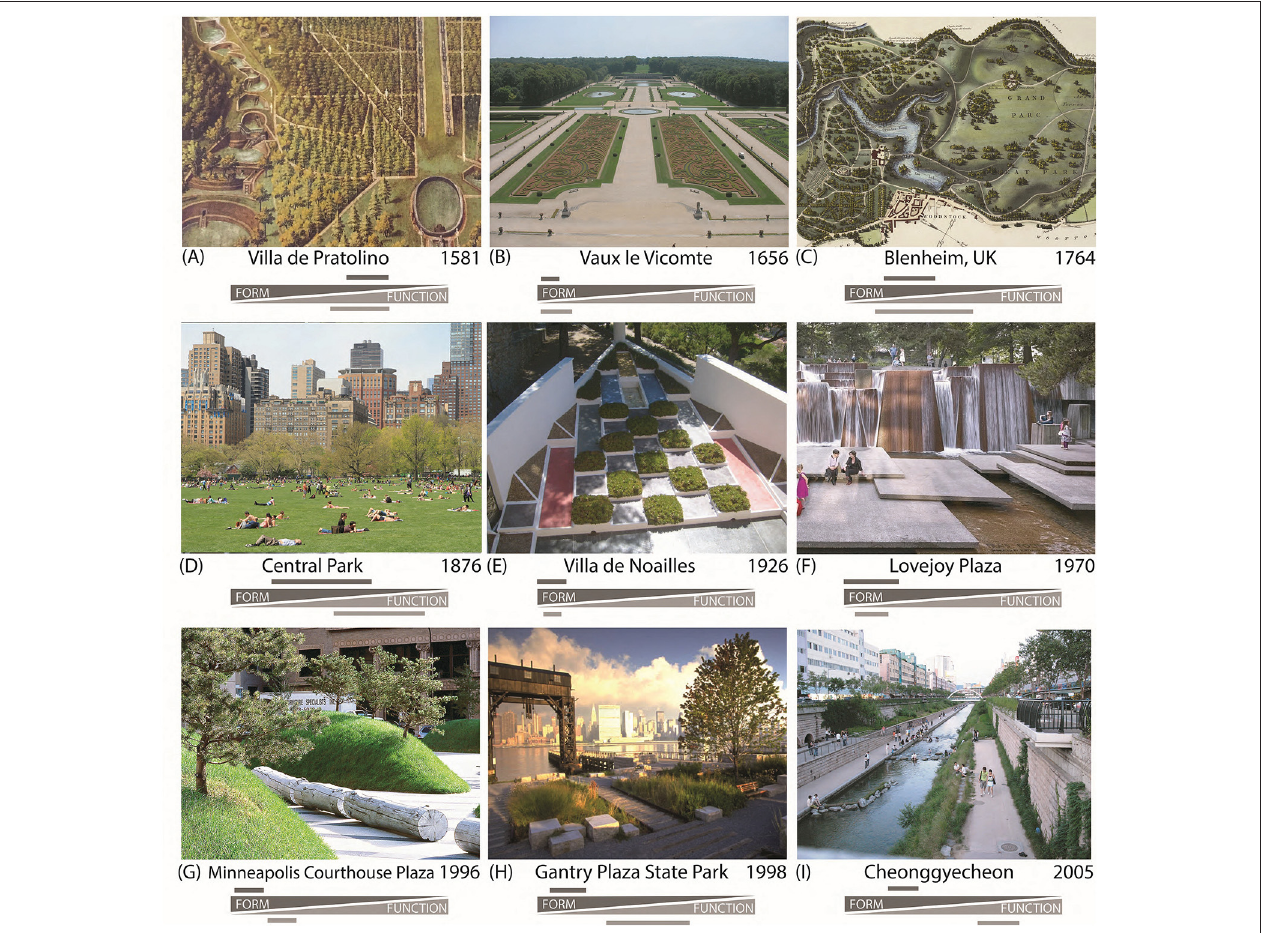
FIGURE 10 | Representative shifts in the attitude and aesthetics of form and function in landscape architecture (images) and the relative importance of form and function from ecological and design standpoints (“sliders” below the images). The color photographs illustrate particular designed landscapes arranged in chronological order. The “sliders” underneath them reflect the relative emphasis of form (dark gray) and function (light gray); the bars above and below the sliders reflect the qualitative magnitude (Form: left to right = large to small; Function: right to left = small to large) and apparent range (length of the bar). (A) Abstraction and form influenced a managed forest and waterway converted into a series of pools in a partially constructed natural fountain in the Italian garden at the Villa di Pratolino. Functions, such as direct path connections and flow of water influenced the aesthetically-driven form of the large forested area and waterway. (B) André le Nôtre’s French garden, Vaux-le-Vicomte, abstracted nature and carved geometric forms onto the landscape using vegetation, water, and paths. The symmetric landscapes represented power and created a sense of theater; ecological function was irrelevant. (C) The extensive landscaped park, woodlands, and formal gardens of the English Picturesque Blenheim Palace (Oxfordshire, England) included clumps of forest arranged around large sinuous water bodies across hills to create a series of naturalist views. The idea of nature and organic form was crafted through extensive grading and manipulation to imitate nature visually rather than functionally. (D) Frederick Law Olmstead’s Central Park in New York imported the concepts from the English garden into an urban area and initiated large park designs across US cities. The park introduced the picturesque and naturalistic style. (E) In the Garden at Villa de Noailles, Gabriel Guevrekian created a highly geometric and artificially-conceived landscape influenced by Cubist painting. The project was, in part, a critical response to the Modernist assertion that form following function should drive design. (F) The Lovejoy Plaza (formerly Ira Keller Fountain) by Lawrence Halprin Associates with Angela Danadjieva is part of the Portland Open Space Sequence. The project introduced a metaphorical mountain cascade that falls through a series of fissured concrete geometric forms to create crags and eddies as part of a waterfall and adjacent riparian zone. The forms have been aestheticized and turned into stepping and seating platforms. The sound of the water and the cascading pattern and microclimates mimic the natural mountain cascade. (G) Martha Schwartz’s Minneapolis Courthouse Plaza created a highly orchestrated and form-driven metaphorical landscape of drumlins and cut logs to represent, respectively, the memory of geological forms and the state’s history of timbering. (H) Gantry Plaza State Park by Thomas Balsey Associates reclaimed and remediated an industrial waterfront. This project used an organic aesthetic organized around industrial ruins to create both ecosystem services and programmatic values. (I) Cheonggyecheon is a public recreational retrofit of a former highway infrastructure.